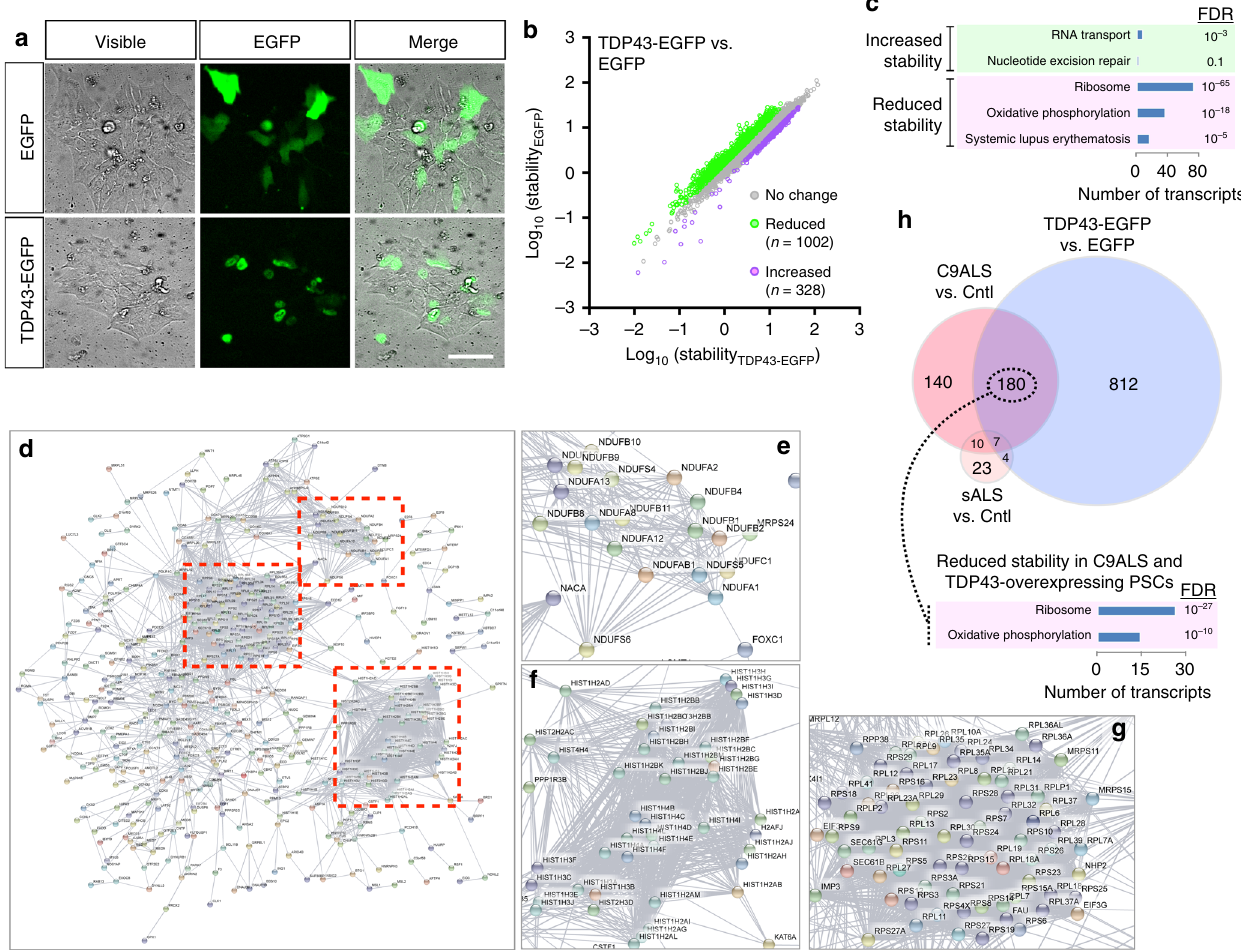
Fig. 4 TDP-43 overexpression recapitulates RNA instability in control iPSCs. a Exogenous overexpression of EGFP and TDP-43 fused to EGFP (TDP43- EGFP) in control (Cntl) iPSCs. Scale bar, 100 µ m. b Scatter plot for 1330 transcripts showing altered stability ≥ 1.5-fold in TDP43-EGFP overexpressing iPSCs, in comparison to EGFP-expressing cells, performed in triplicate. Gene ontology ( c ) and STRING analysis ( d , excluding ubiquitin) for transcripts demonstrating altered stability in TDP43-EGFP overexpressing iPSCs. e − g Higher resolution views corresponding to boxed areas in d . h 180 transcripts were commonly destabilized in C9ALS and TDP43-EGFP-expressing cells. Among these transcripts, the ribosome and oxidative phosphorylation